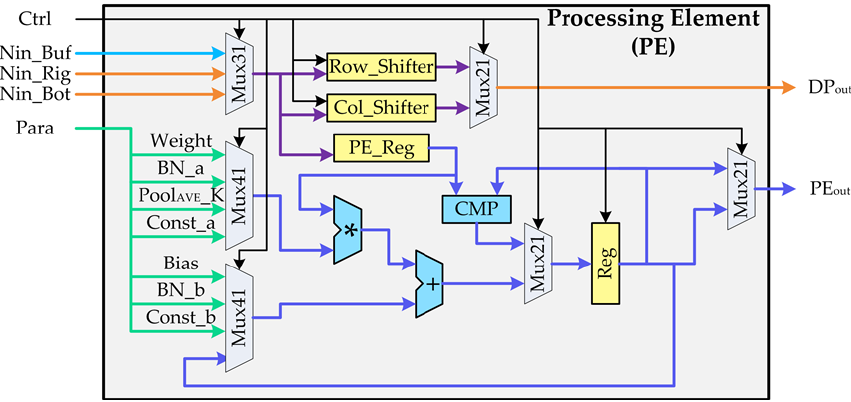
Figure 5. The structure of the processing element.